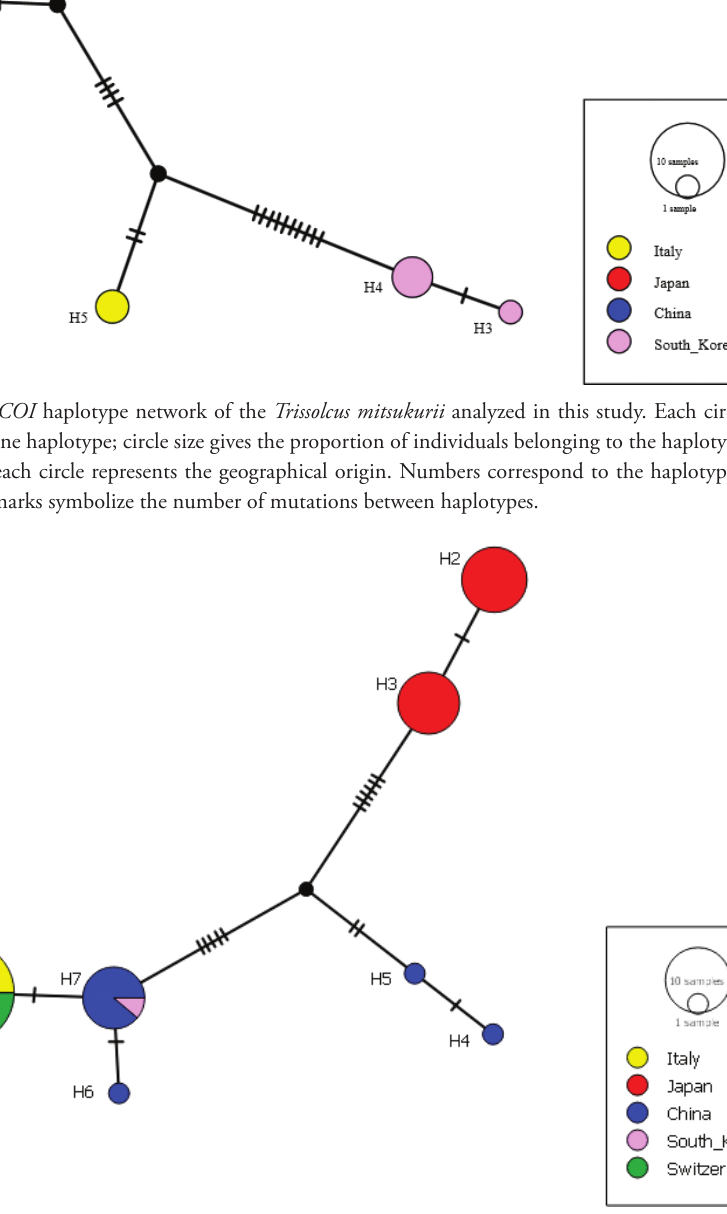
Figure 12. COI haplotype network of the Trissolcus japonicus analyzed in this study. Each circle corre- sponds to one haplotype; circle size gives the proportion of individuals belonging to the haplotype. The color inside each circle represents the geographical origin. Numbers correspond to the haplotype num- bers. Hatch marks symbolise the number of mutations between